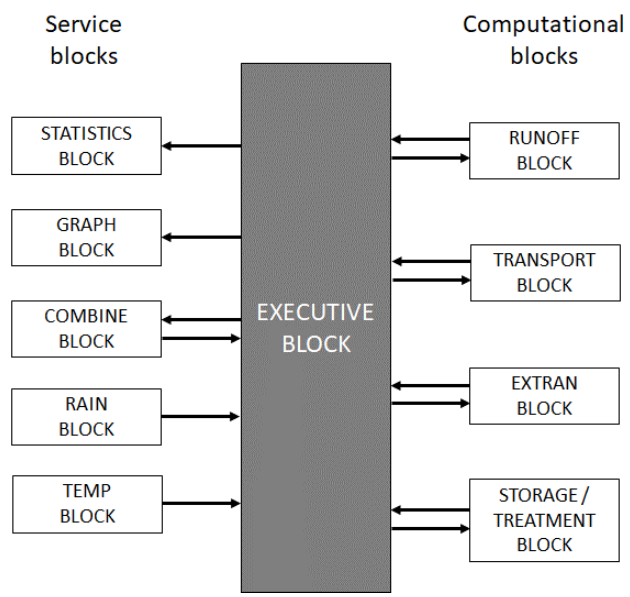
Figure 3. Structure of SWMM model.